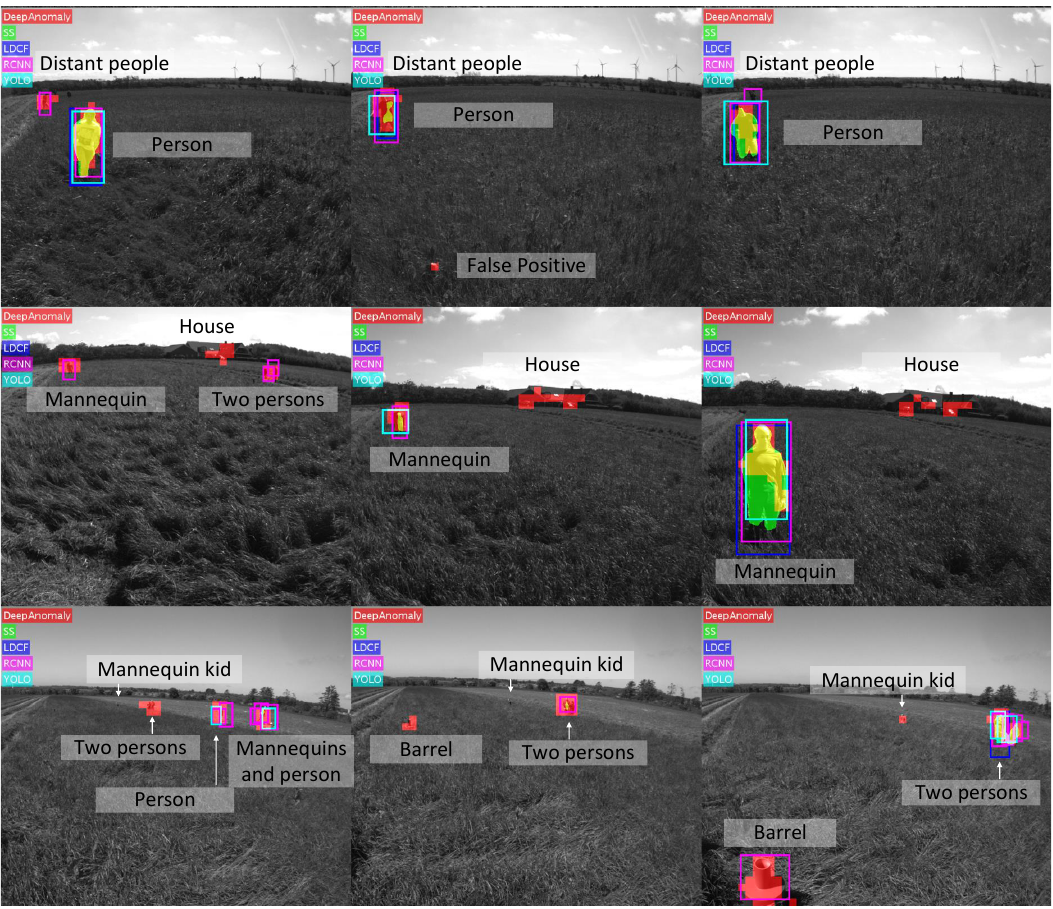
Figure A1. Detection examples of 15 image with humans.